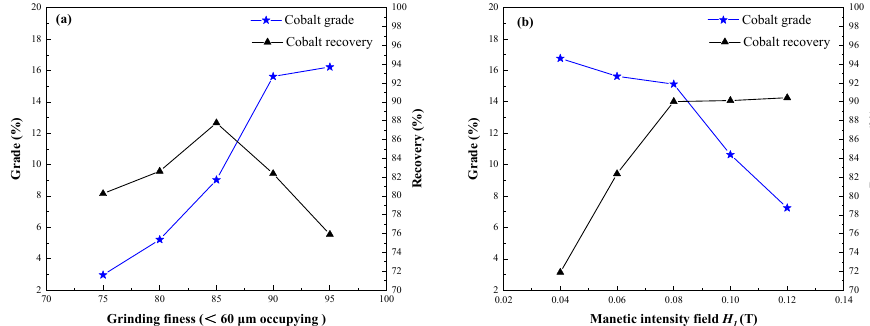
Figure 12. Effect of grinding fineness and magnetic intensity field on cobalt extraction: (a)-Grinding fineness; (b)-Magnetic intensity filed.